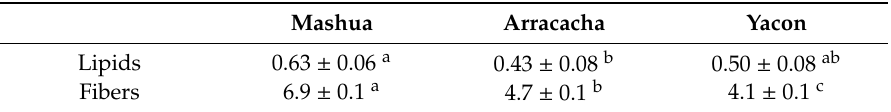
Table 2. Variation in lipid and fiber contents in Andean roots and tubers g 100 g DM − 1 ). For each species, averages across countries and varieties (g 100 g dry matter − 1 or mg kg dry matter − 1 ). Among species, results with di ff erent letters are significantly di ff erent at p < 0.05 (LSD).